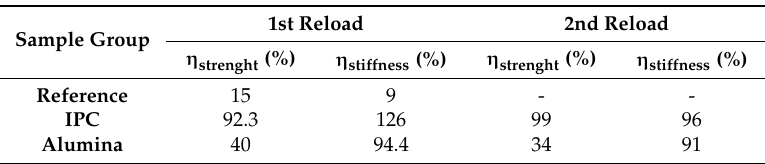
Table 2. Average mechanical recovery for the beams carrying a piping network and loaded under three-point-bending.